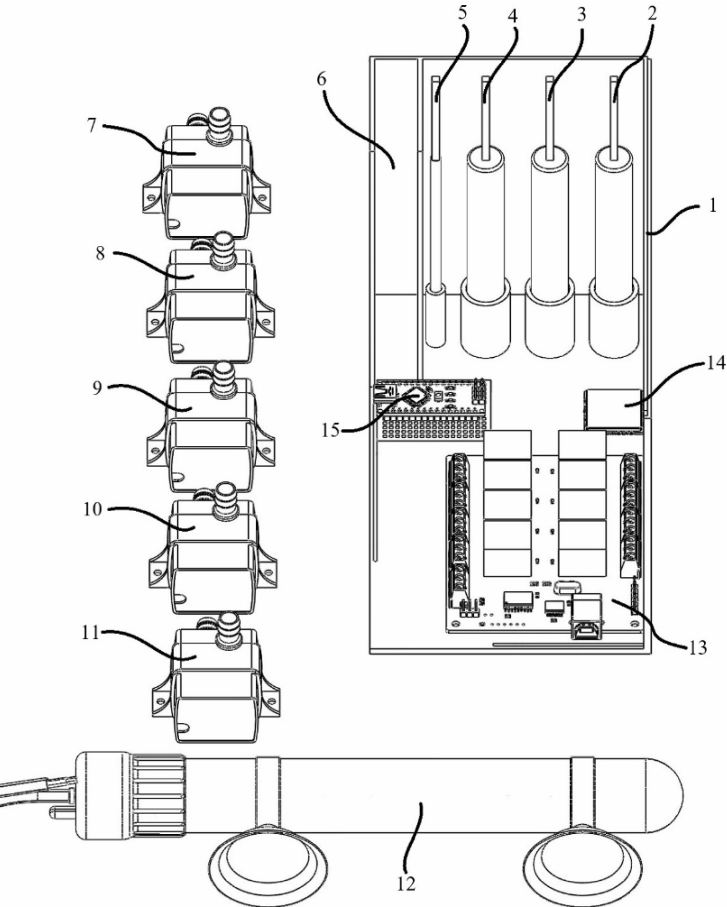
Figure 2. Images of the kit. Box design (1), the placement of the dissolved oxygen sensor (2), the location of the electrical conductivity measurement sensor (3), the location of the pH sensor (4), the location of the temperature sensor (5), the battery housing section (6), the submersible pump used to control the dissolved oxygen amount (7), the submersible pump used to decrease the pH value (8), the submersible pump used to increase the pH value (9), the submersible pump used to reduce the EC value (10), another submersible pump (11), the heater (12), the relay circuit (13), the GSM module (14), and the Arduino nano microcontroller